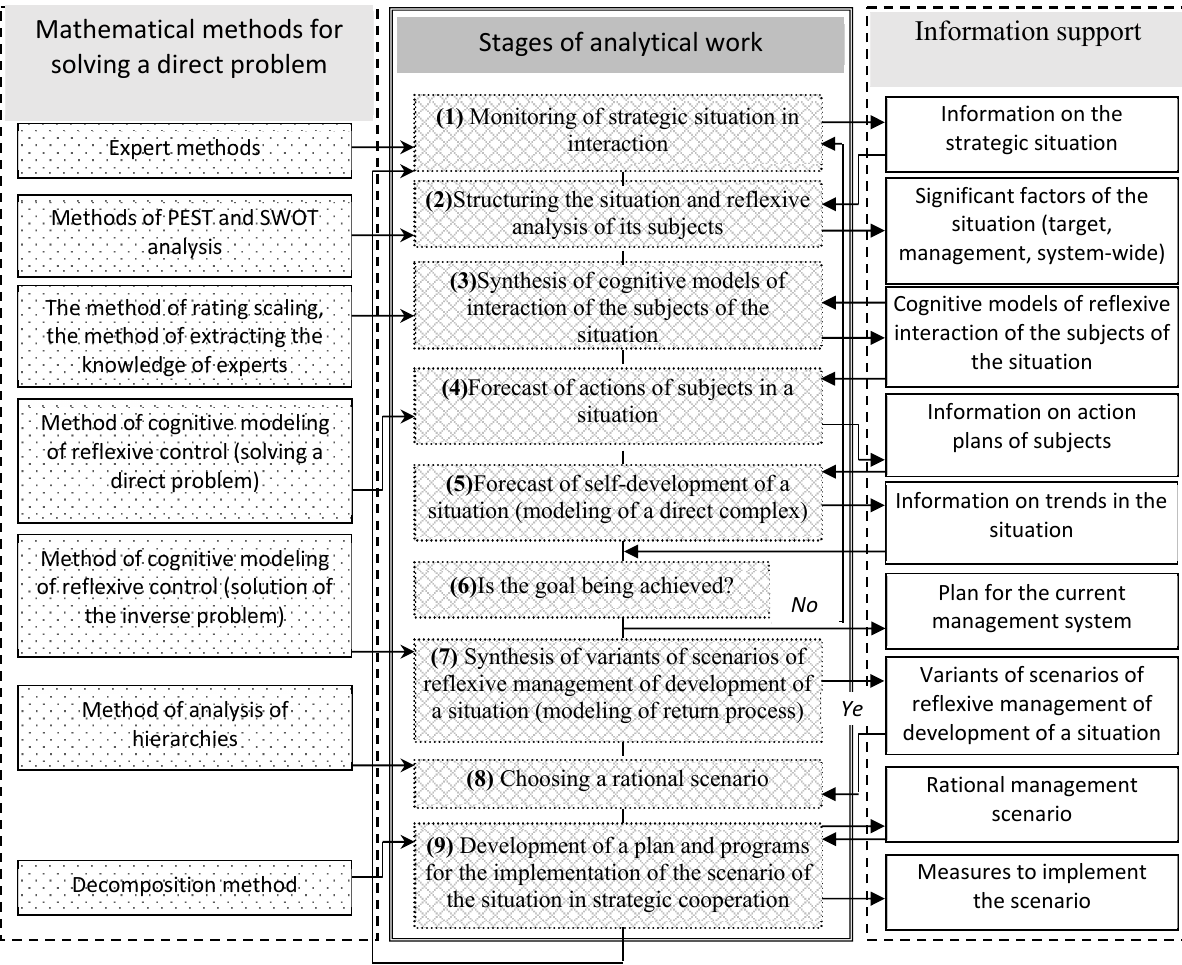
Fig. 3. Technological scheme of ensuring enterprise economic security